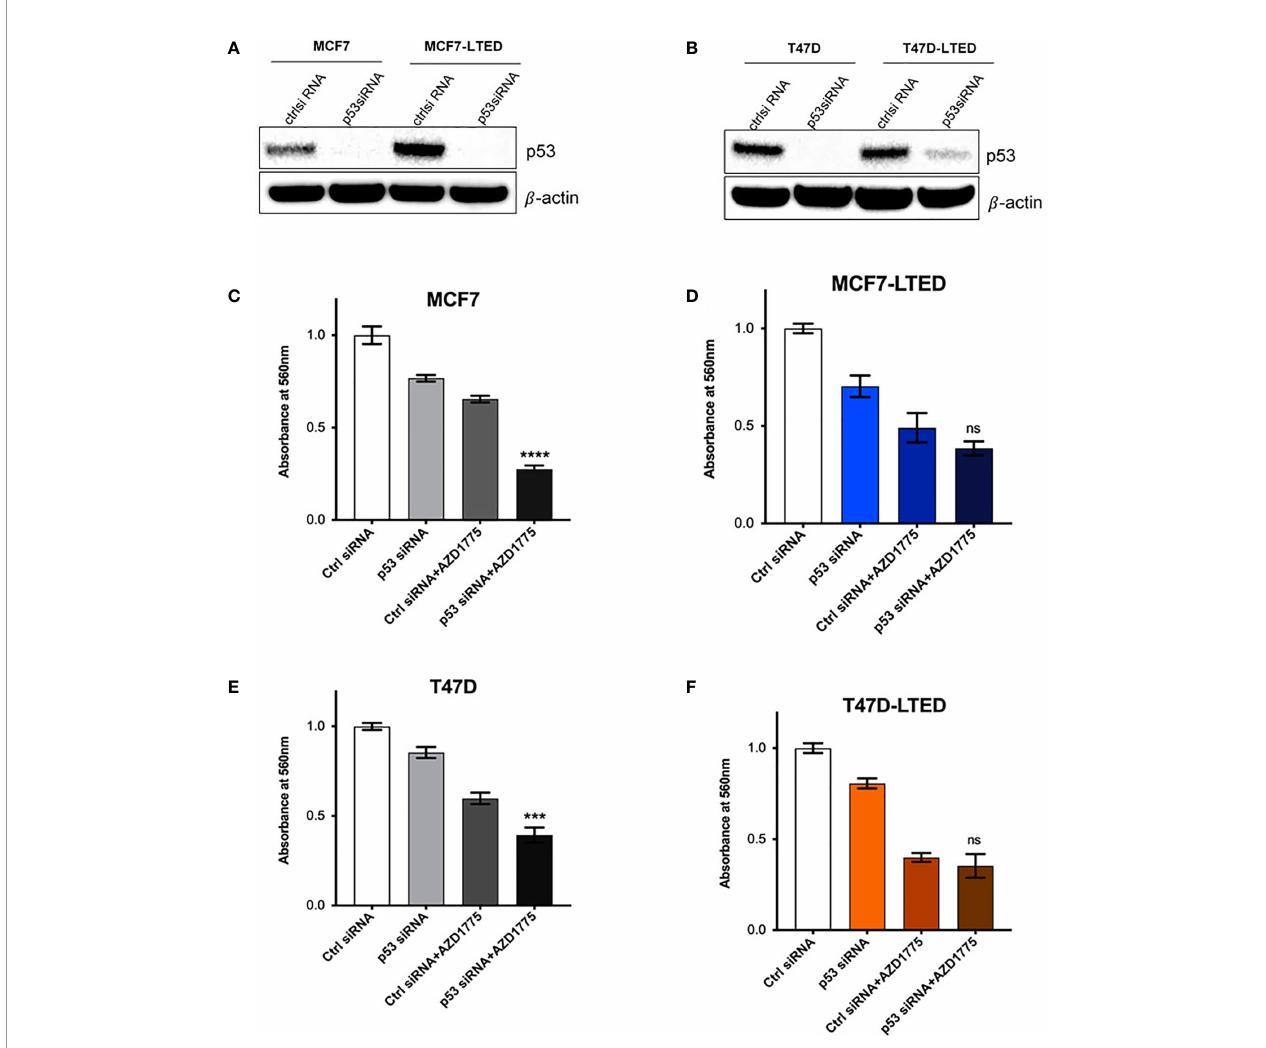
FIGURE 9 | Knockdown of p53 enhances AZD1775 mediated inhibition of cell growth in parental MCF7 and T47D cells. (A, B) Parental MCF7 and T47D and their respective LTEDs were transfected with p53 siRNA or scramble negative control (ctrl) siRNA for 72h. Whole cell lysates were subjected to immunoblotting with p53 antibody to con fi rm knockdown; b -actin was used as protein loading control. (C – F) Following 24h post transfection, cells were treated with 500nM AZD1775 for another 48 h and cell number was measured using the crystal violet assay. ***p < 0.001, ****p < 0.0001 or ns (not signi fi cant) (ANOVA) for cell number with p53 siRNA+AZD1775 compared to Ctrl siRNA+AZD1775 for respective cell lines. All blots and proliferation assays are from three independent experiments